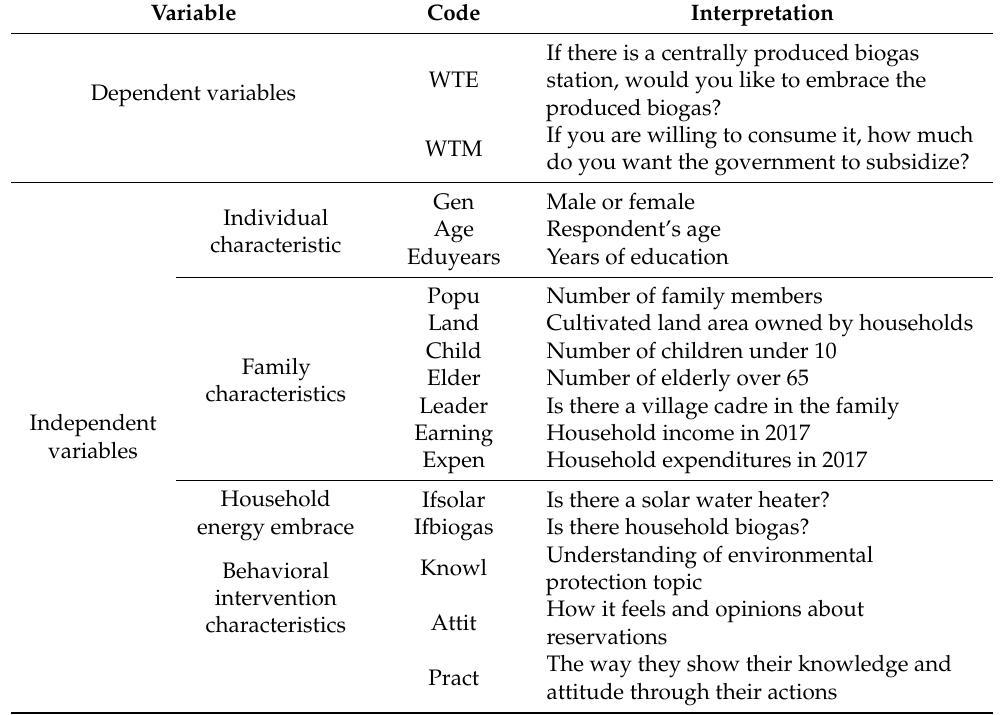
Table 1. Definition and interpretation of